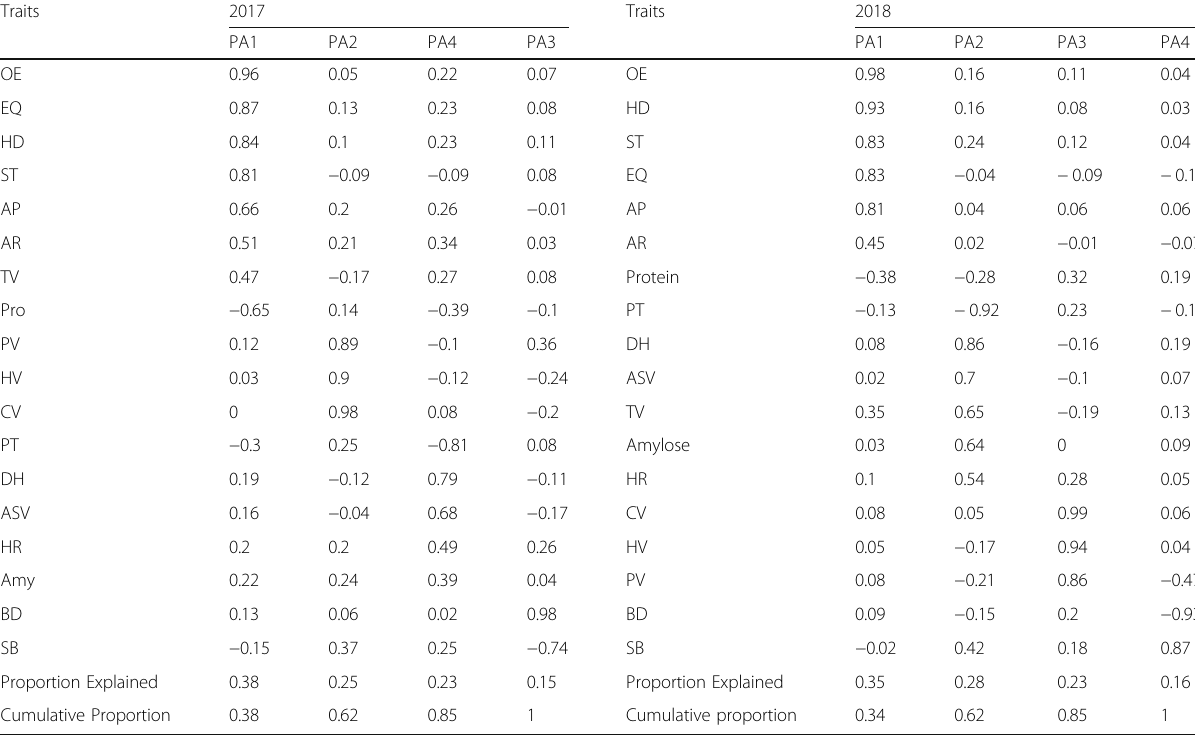
Table 2 Factor analysis with orthogonal rotation of the 17 traits evaluated using the RIL population